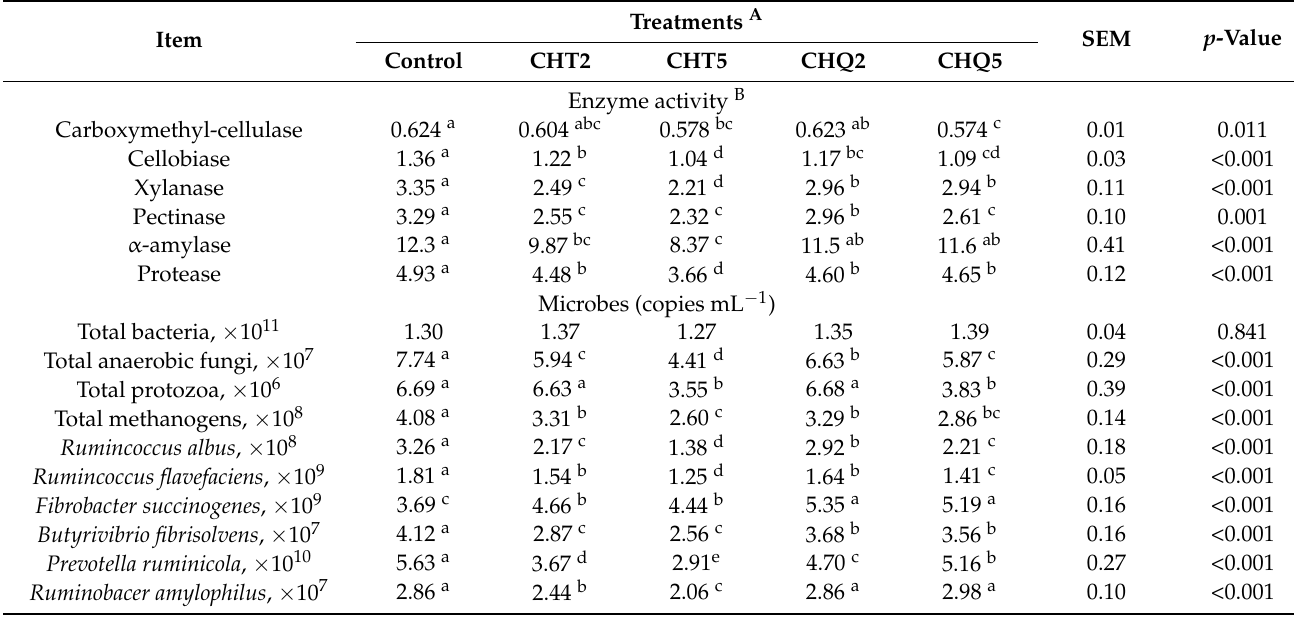
Table 4. Ruminal enzyme activity and microbes in the in vitro fermentation cultures receiving untreated or tannin-treated alfalfa